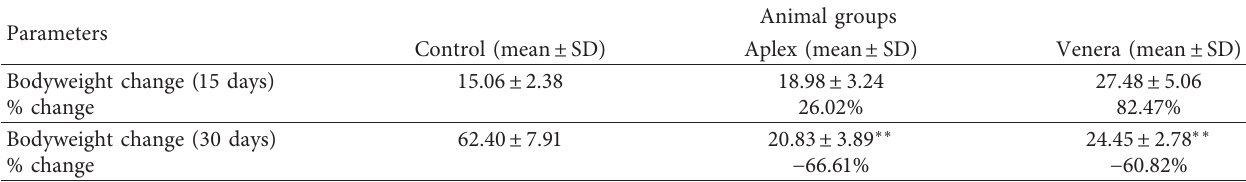
Table 1: Percentage bodyweight change in control and treated animal